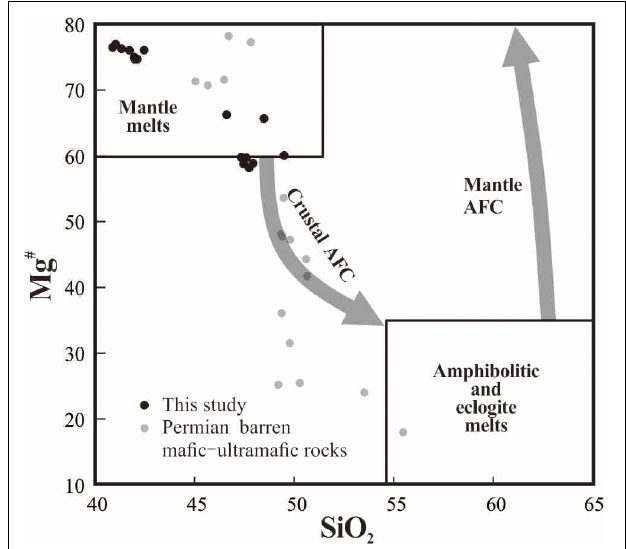
FIGURE 8 | Mg # vs. SiO 2 plots for the Xiwanggou mafic–ultramafic rocks. Gray circle data for Permian mafic–ultramafic intrusions are from Jiadang and Bairiqili areas (Xiong et al., 2011b; Kong et al., 2018).